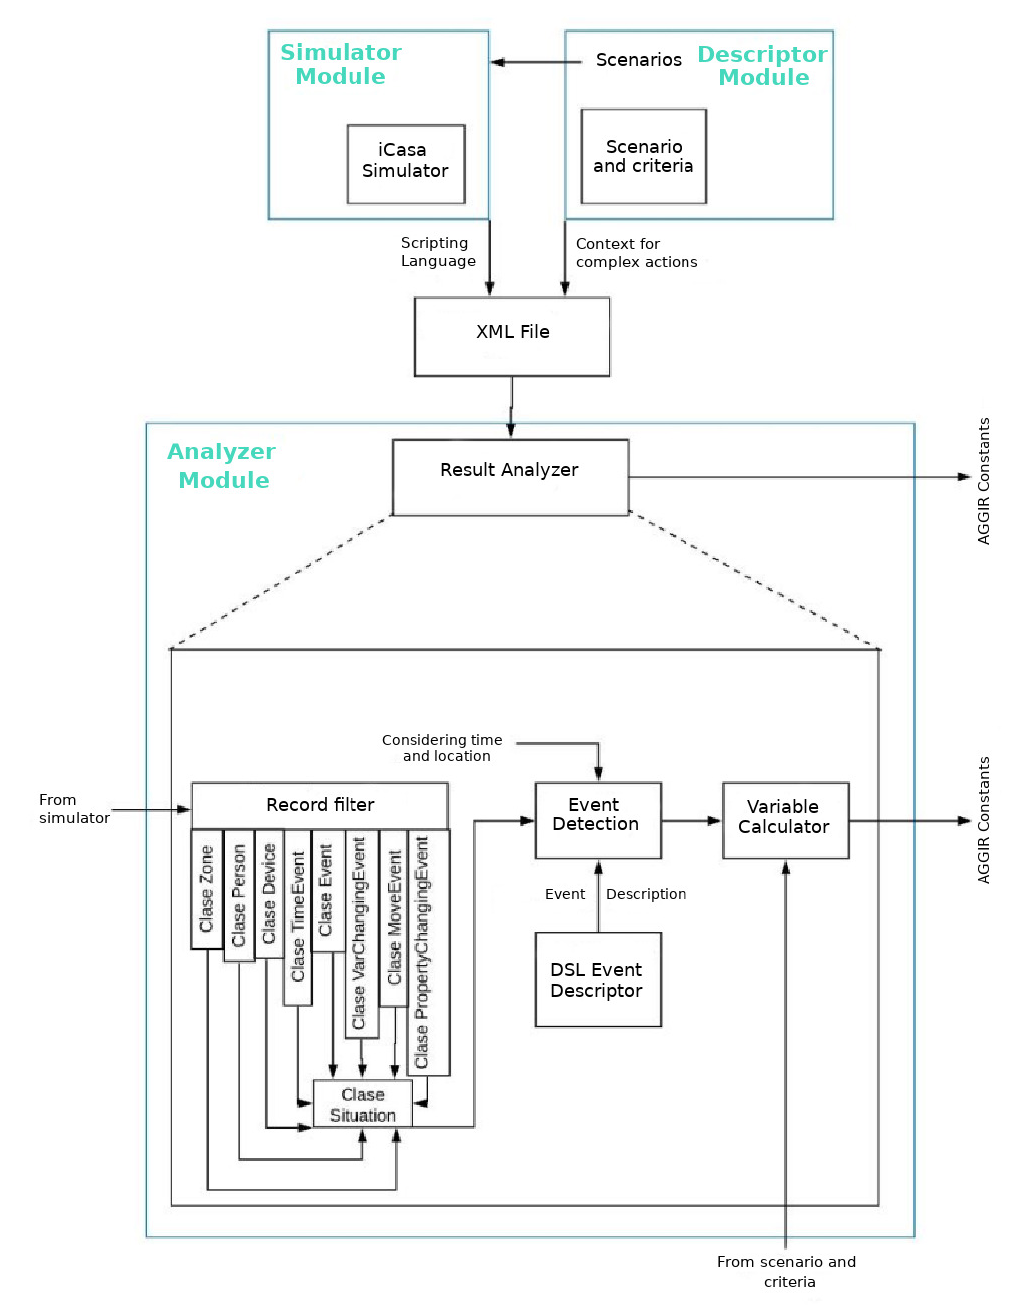
Figure 7. General Architecture of the proposed